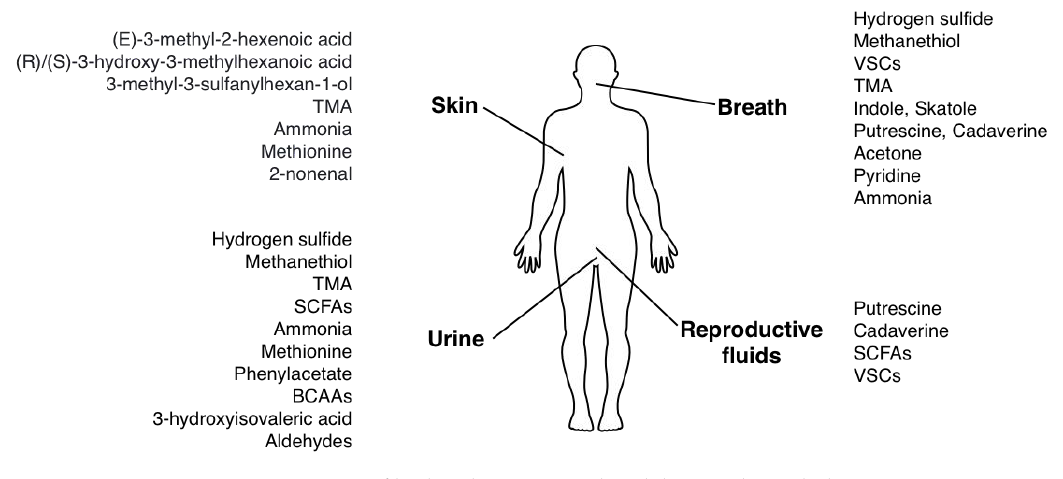
Figure 1. Origins of body odor associated with bacterial metabolites.